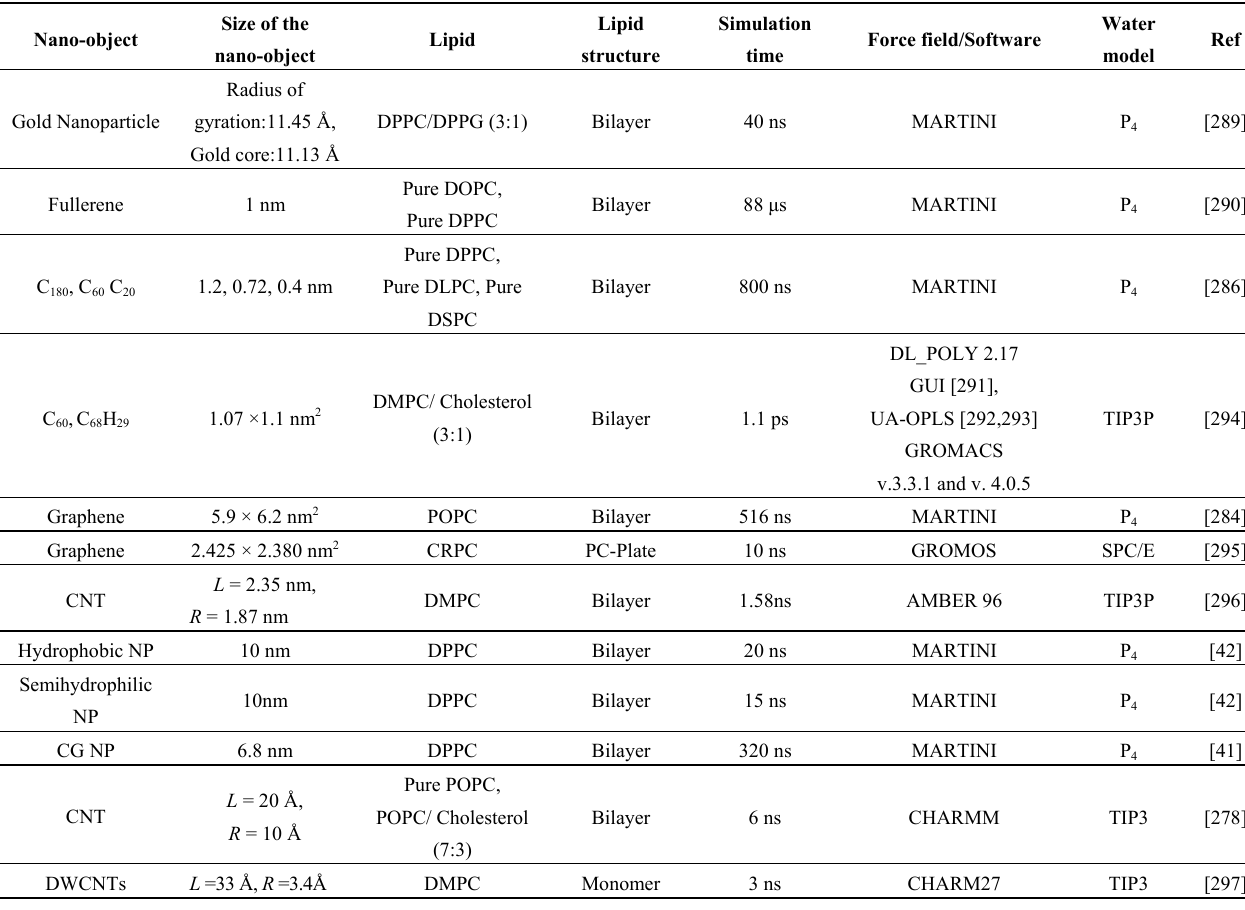
Table 1. Molecular dynamics simulations of bilayer based hybrid